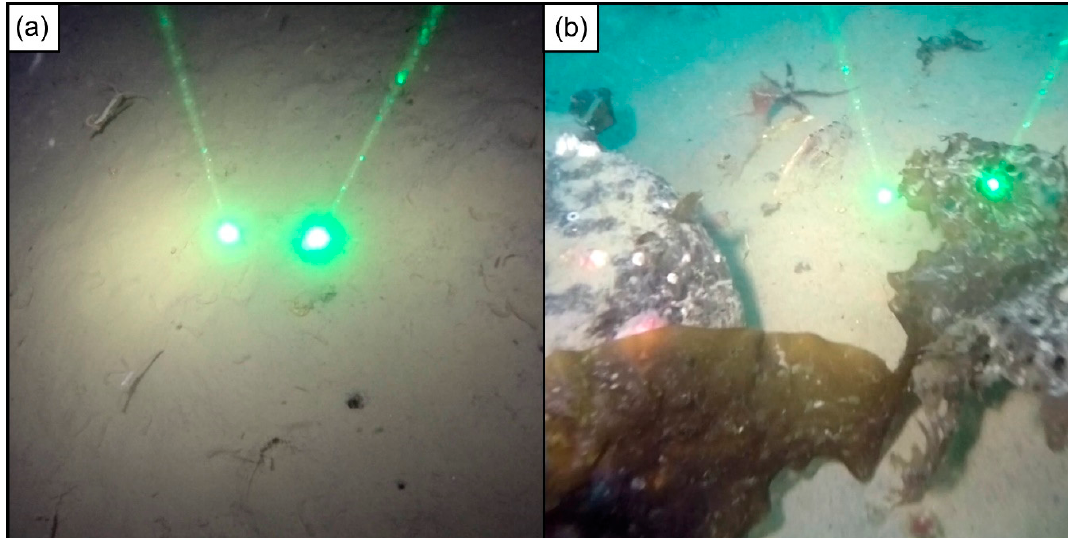
Figure 6. Grain size composition of sediment samples with class membership for the three schemes.